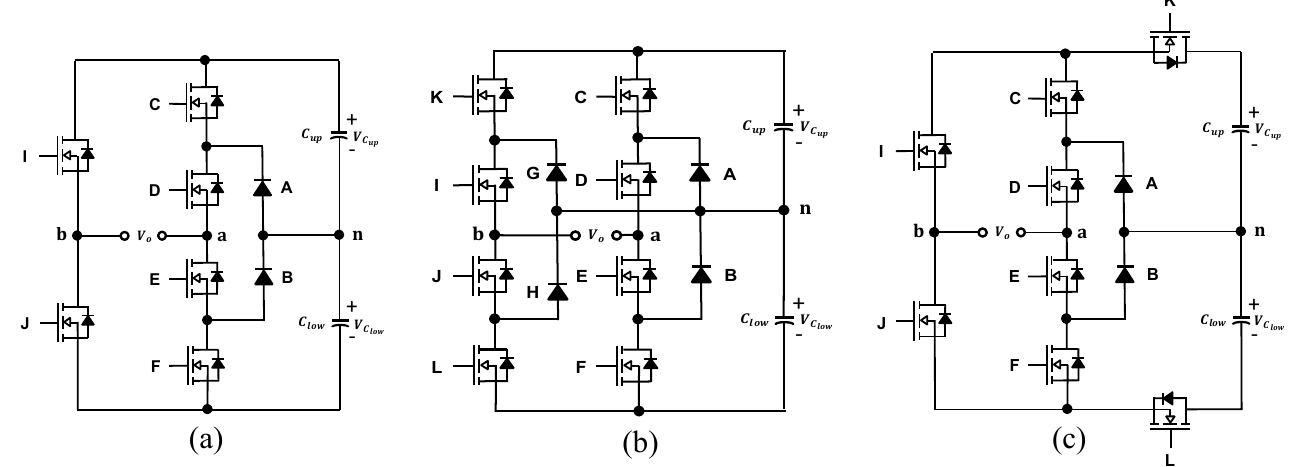
Figure 1. Single-phase NPC five-level converters; ( a ) conventional simplified-bridge topology [15–18], ( b ) full-bridge topology [20–26], and ( c ) proposed topology. Table 1. Comparison of five-level NPC